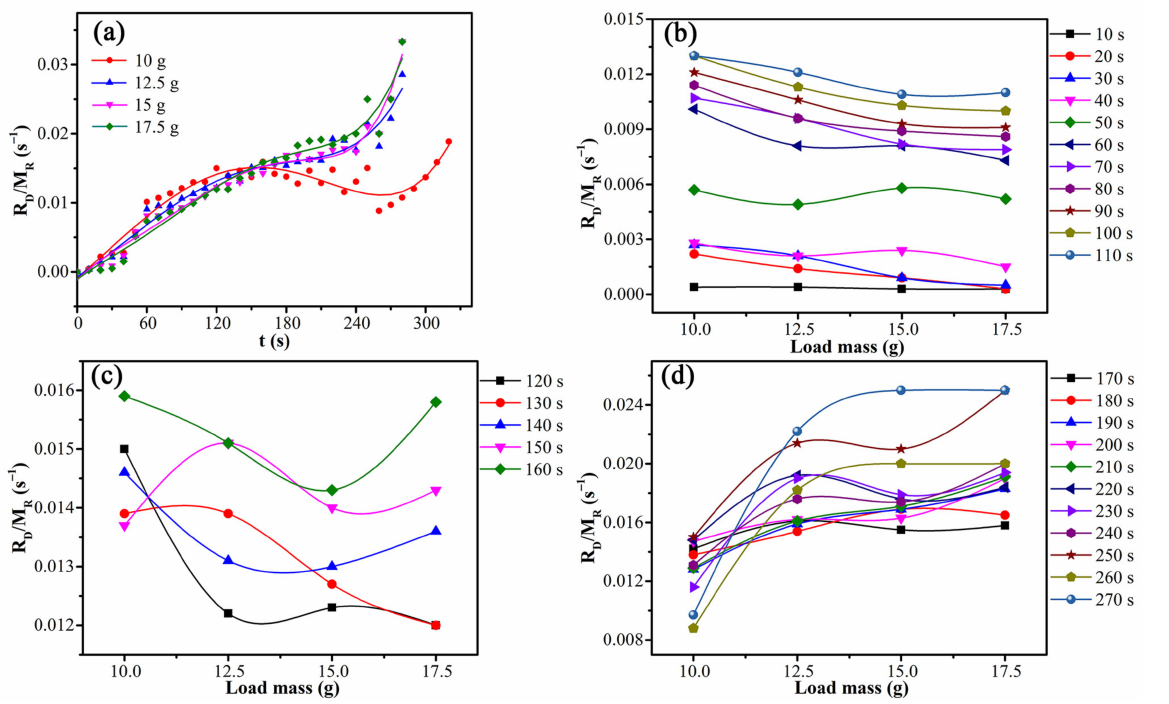
Figure 12. Variations of drying rate constant with time and load mass: ( a ) the entire process, ( b ) before 110 s, ( c ) 110 s–160 s, and ( d ) after 160